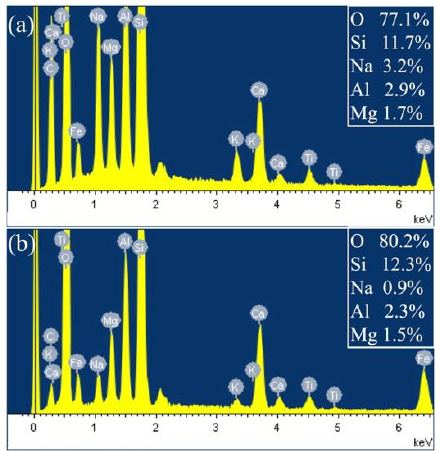
Figure 2. Energy-dispersive spectroscopy (EDS) images of ( a ) unmodified BFs and ( b ) BFs modified with 7‰ nano-SiO 2 microspheres.